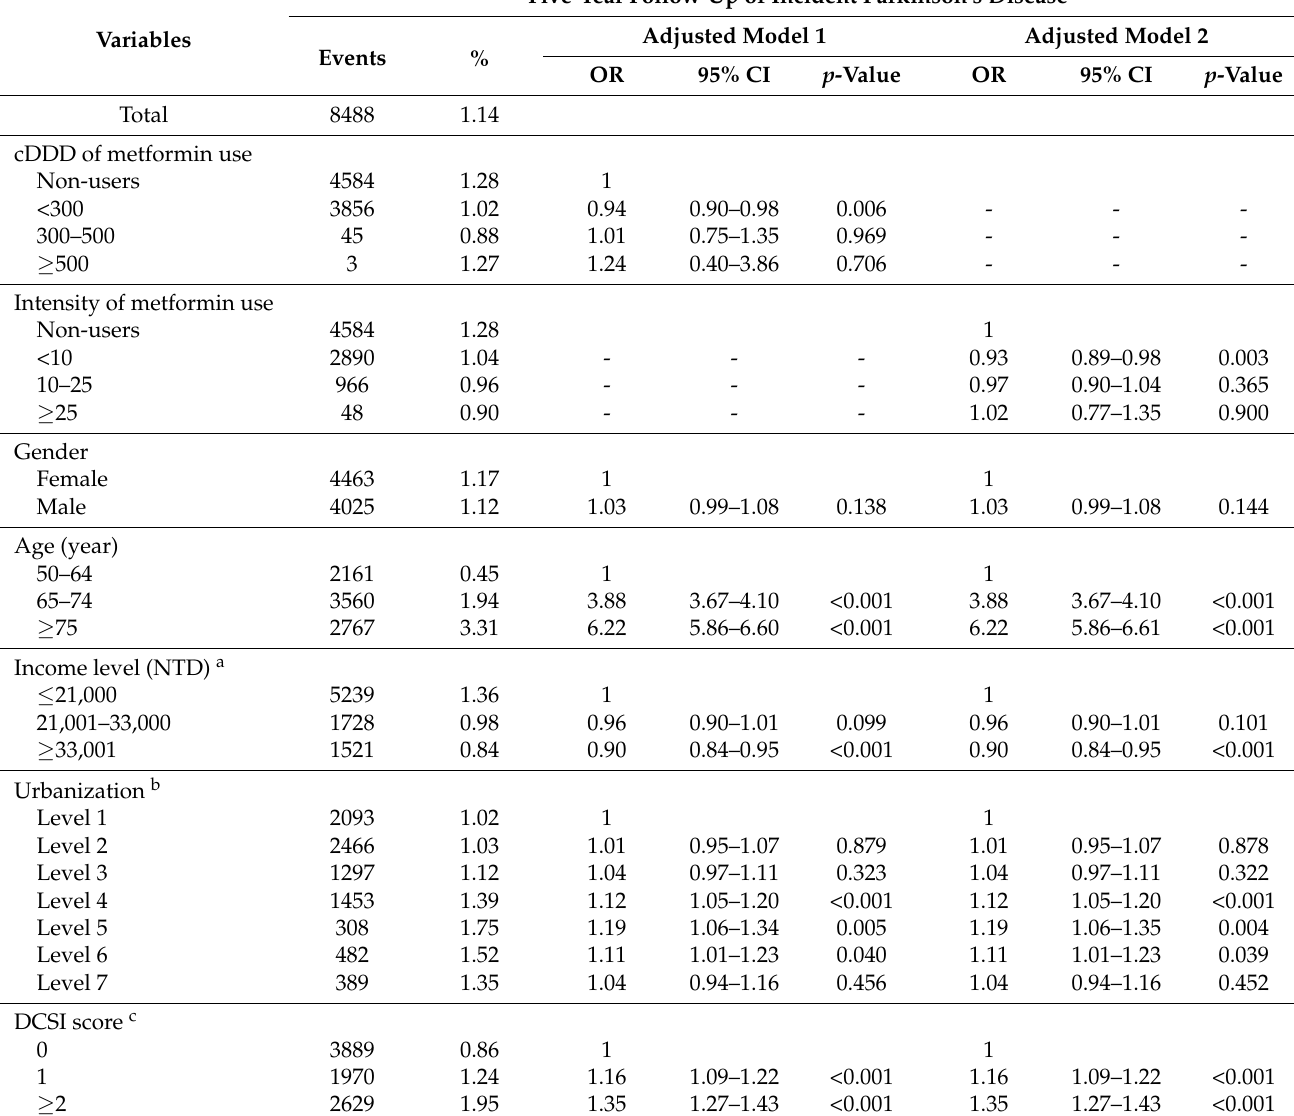
Table 3. Five-year follow-up of incident Parkinson’s disease in new-onset diabetes mellitus patients with metformin